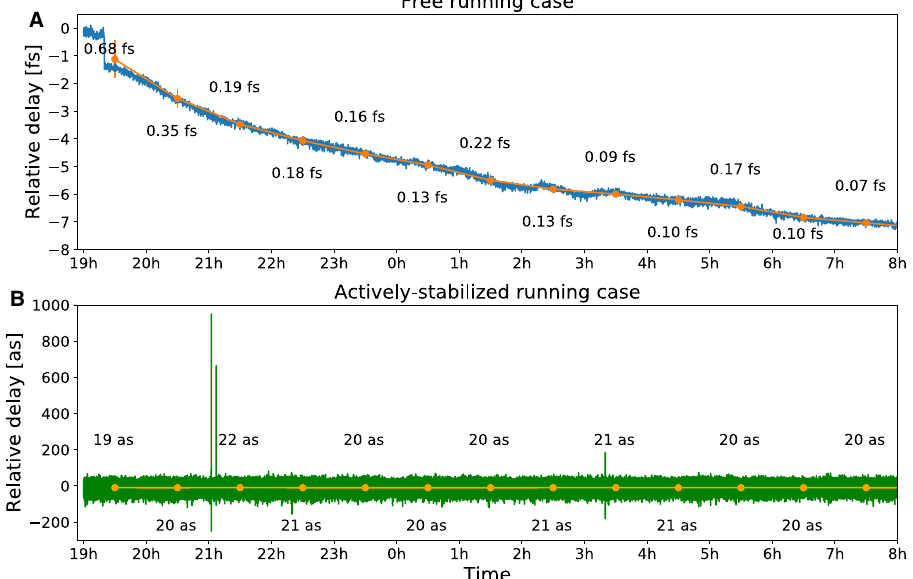
Figure 3. Relative delay in the SXR and mid-IR beam paths. Long-term stability of the relative delay in the SXR and mid-IR beam paths measured overnight for ( A ) the free-running case and ( B ) the actively-stabilized case. The reported numbers represent the RMS value of the measured relative phase over a period of 1 h